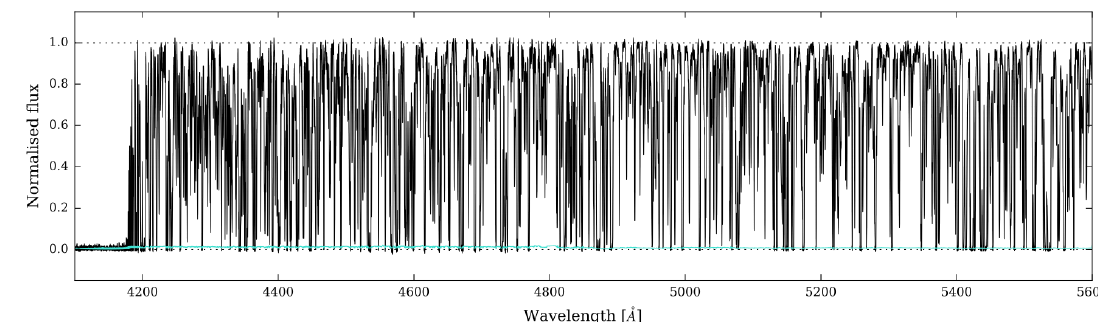
Figure 1. The normalised flux spectrum of PKS1937–101 (weighted stacking of all exposures for illustration only). The Lyman α of the z abs = 3.256 absorber lies at 5171.7Å and the Lyman Limit at 3877.2Å (outside the spectrum). For the z abs = 3.572 the Lyman α is found at 5555.7Å and the Lyman Limit at